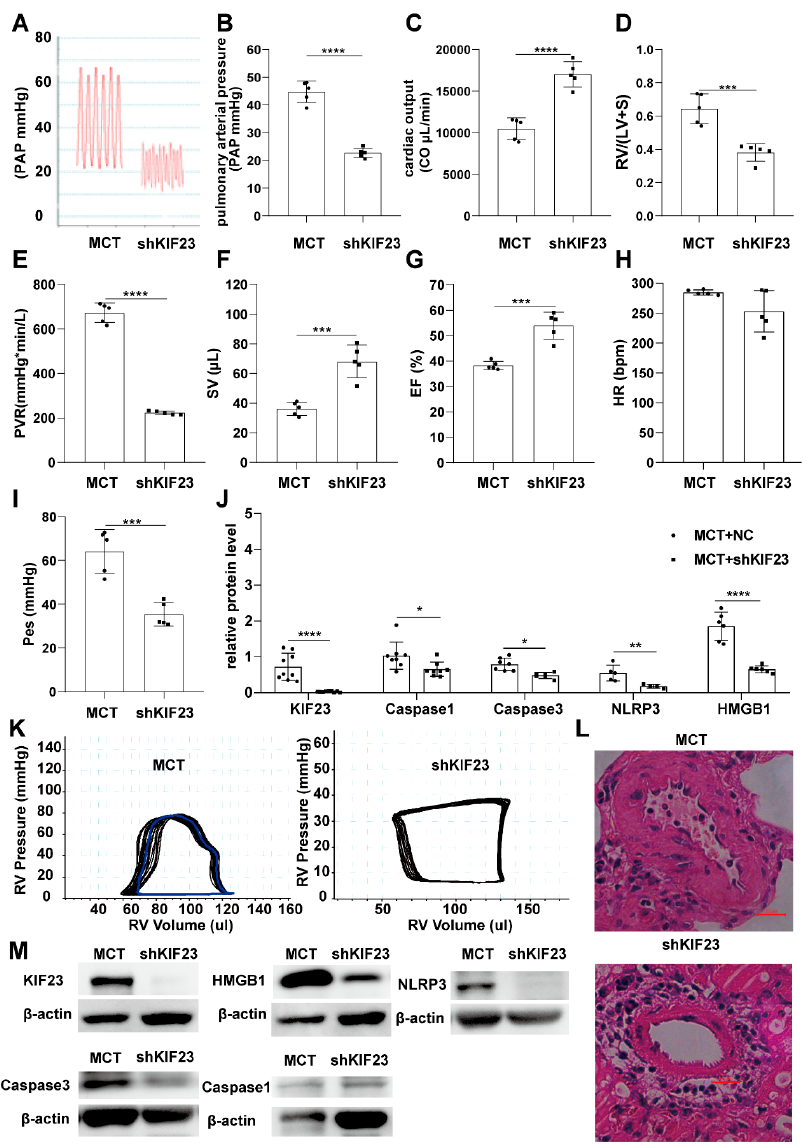
Figure 7. KIF23 knockdown alleviates the process of IPAH. ( A – I ) Present the pulmonary arterial pressure, cardiac out, RV/(LV + S), CO, peripheral vascular resistance, stroke volume, ejection fraction, heart rate, and end-systolic pressure in MCT and shKIF23 groups. ( J ) The protein level of KIF23, Caspase1, Caspase3, NLRP3, and HMGB1 between MCT and shKIF23 groups. ( K ) The PV Loop analysis of right ventricle between MCT and shKIF23 groups. n = 5 per group. * p < 0.05, ** p < 0.01, *** p < 0.001, **** p < 0.0001 versus MCT. Data are mean ± SEM. ( L ) HE staining a picture of the pulmonary artery. ( M ) The protein level of KIF23, Caspase1, Caspase3, NLRP3, and HMGB1 between MCT and shKIF23